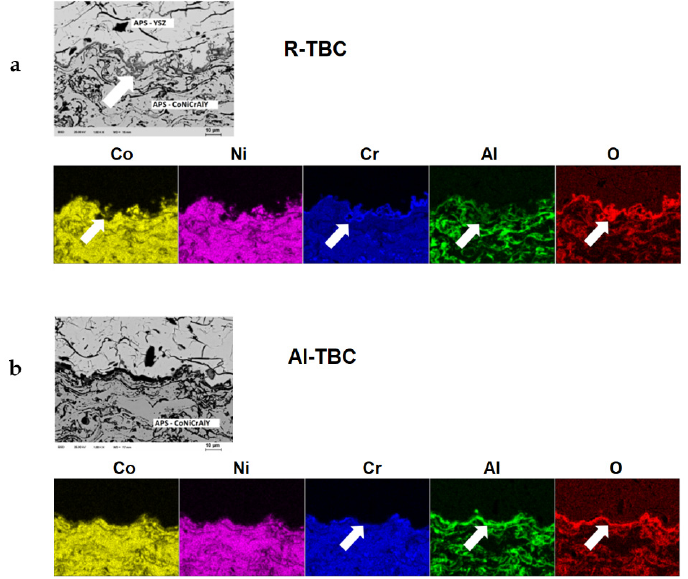
Figure 4. EDX mapping of the TBC systems after one cycle of isothermal exposure: ( a ) R-TBC and ( b ) Al-TBC. The arrows pointing upward indicate the TGO layer in the BC/TC interface. The cross-sectional microstructures of both TBC systems subjected to 100, 300, and 600 h of isothermal exposure are presented in Figure 5. In general, the R-TBC system (Fig- ure 5a,c,e), compared to the Al-TBC system (Figure 5b,d,f), showed extensive TGO for- mation (dark grey regions labelled with “TGO” in Figure 5) in the BC/TC interface. In addition, after 600 h of isothermal exposure, the BC microstructures of the R-TBC system revealed much higher oxidation levels than the BC microstructure of the Al-TBC system (Figure 5e,f).